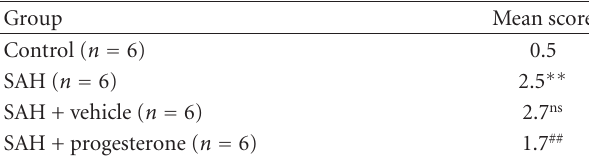
Table 2: Clinical behavior scales in each